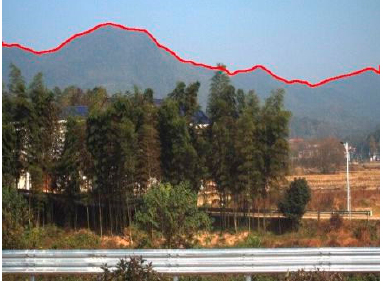
Figure 8. Skyline with FoV of 24°.